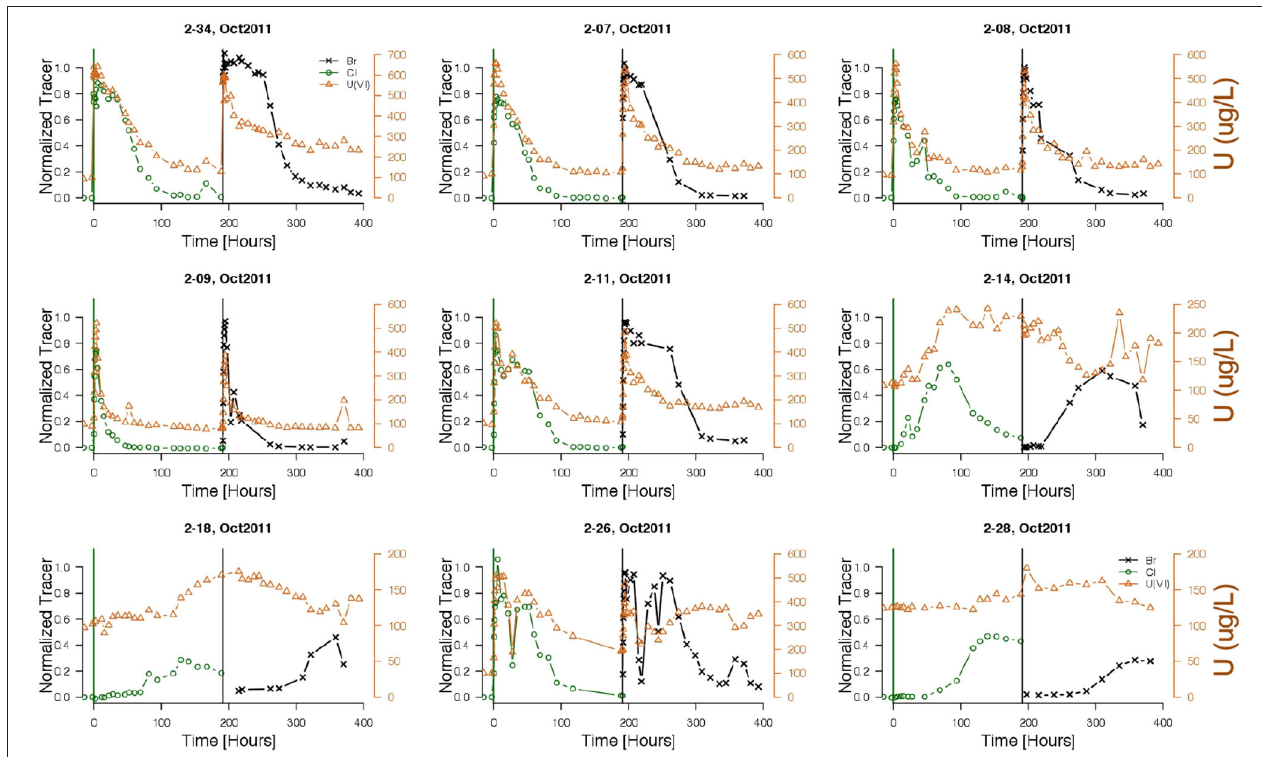
FIGURE 3 | A comparison of conservative tracer and uranium concentrations at the injection well and near-field monitoring wells. Br − was injected in Test 1 and Cl − was injected in Test 2. The two vertical lines represent the starting time of Test 1 and Test 2.